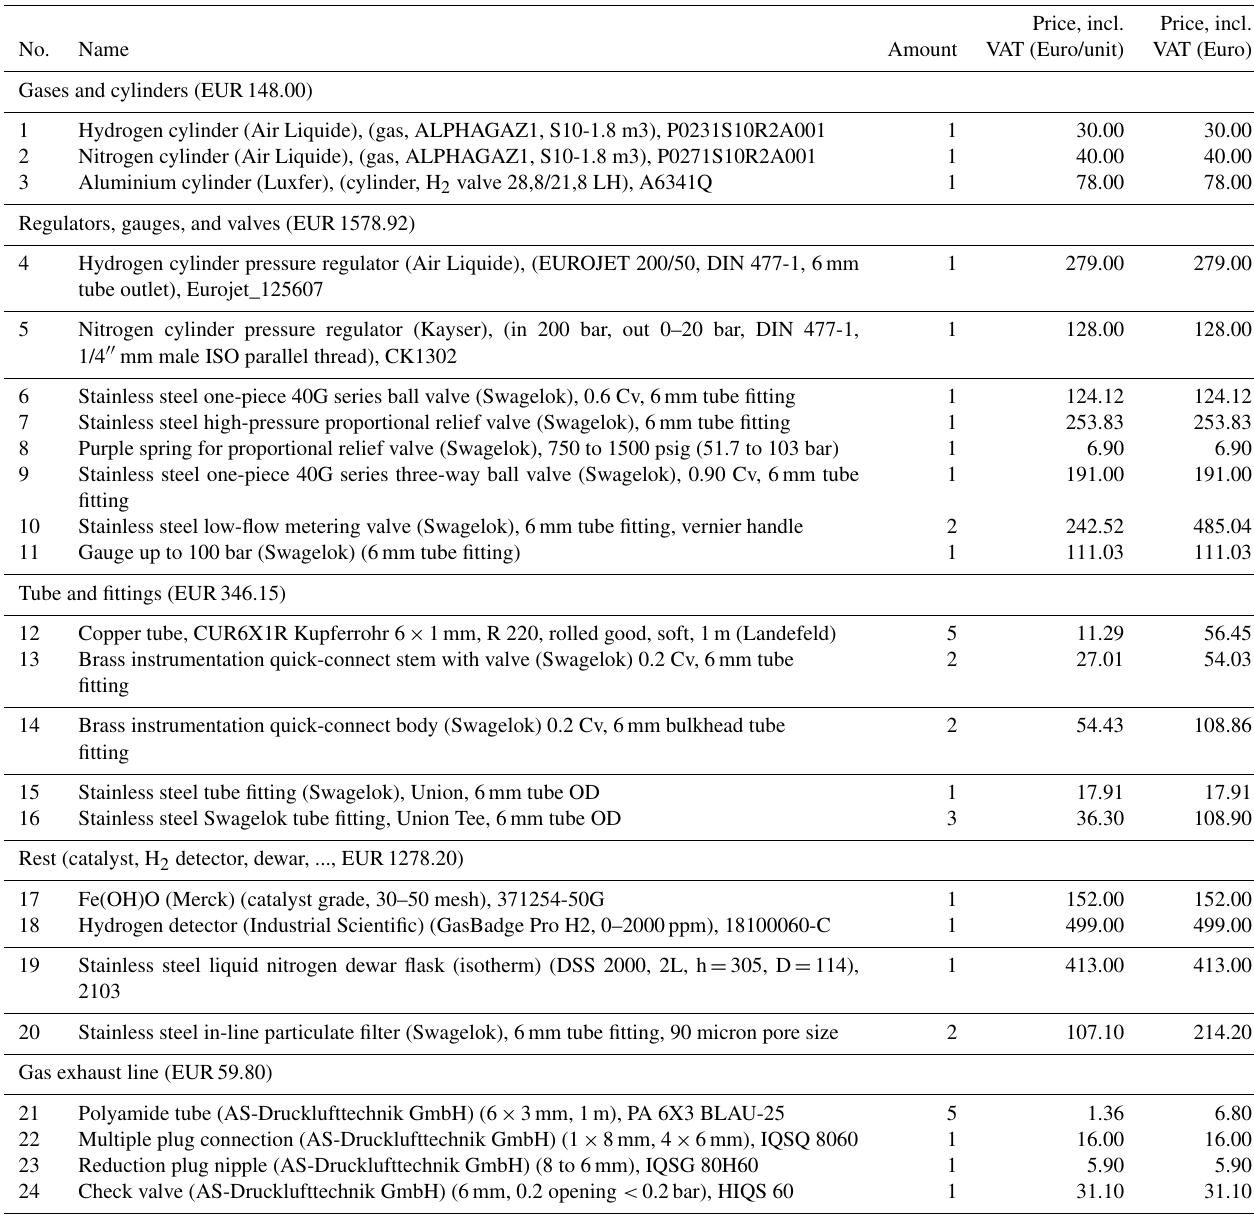
Table A1. Price list of all needed components for the high-pressure PHG. Full list of items required for construction of the portable liquid nitrogen parahydrogen generator (without cart) with 6mm copper connection tubes. Here the following format for item names is used: {Name (company), (specifications), article number}. Given prices include 19% VAT.